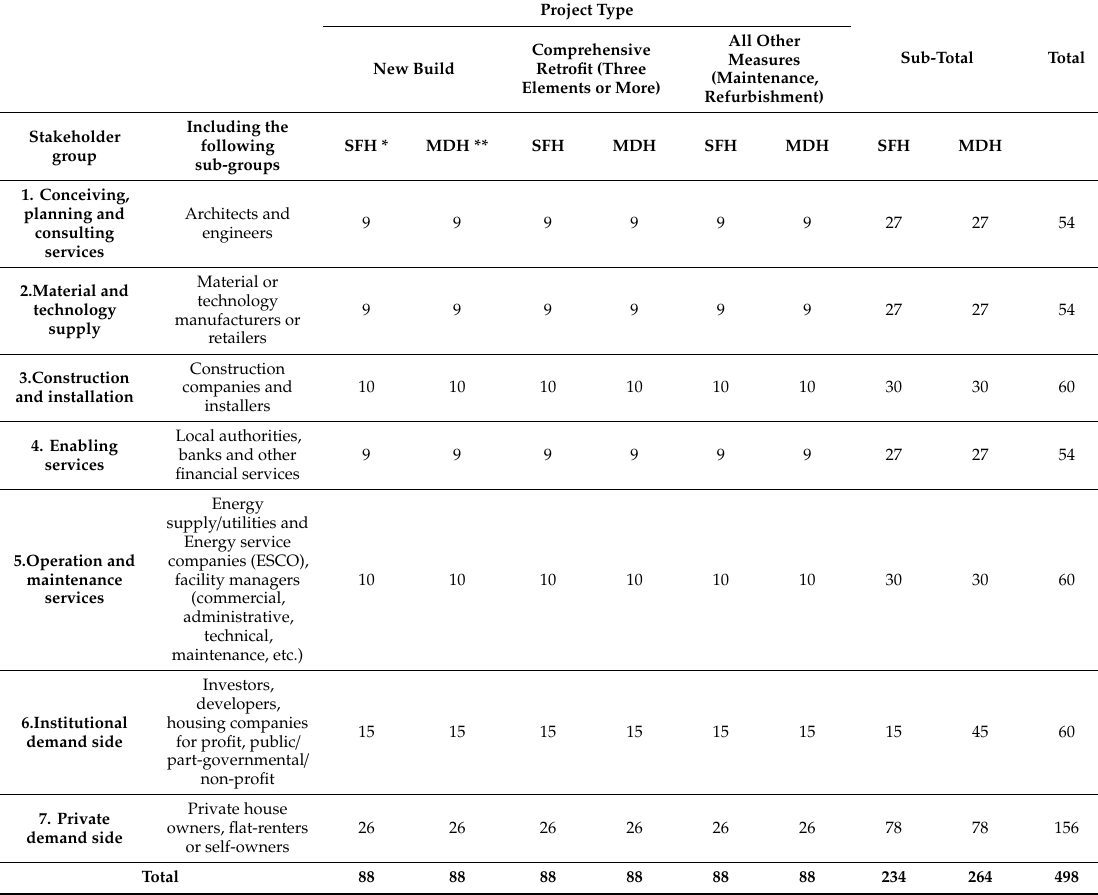
Table A1. Minimum quotas per stratum defined in the